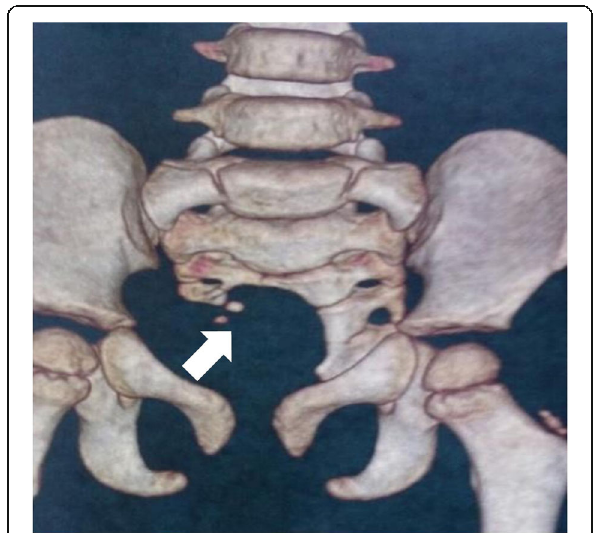
Fig. 2 3D reconstructed view of CECT pelvis showing sacral bony defect (scimitar sacrum) [white